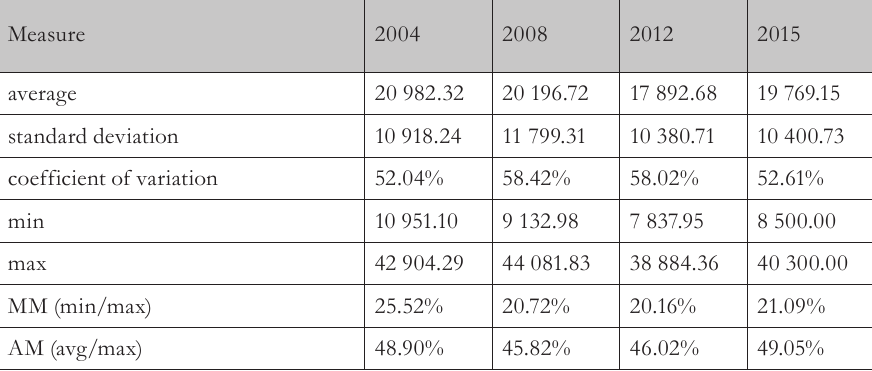
Tab. 4 – Selected measures describing the level of the regional GDP pc level and its diversifica- tion in Hungary in selected years [data in EUR according to PPS (2015=100)]. Source: Own calculations based on Eurostat database (access: